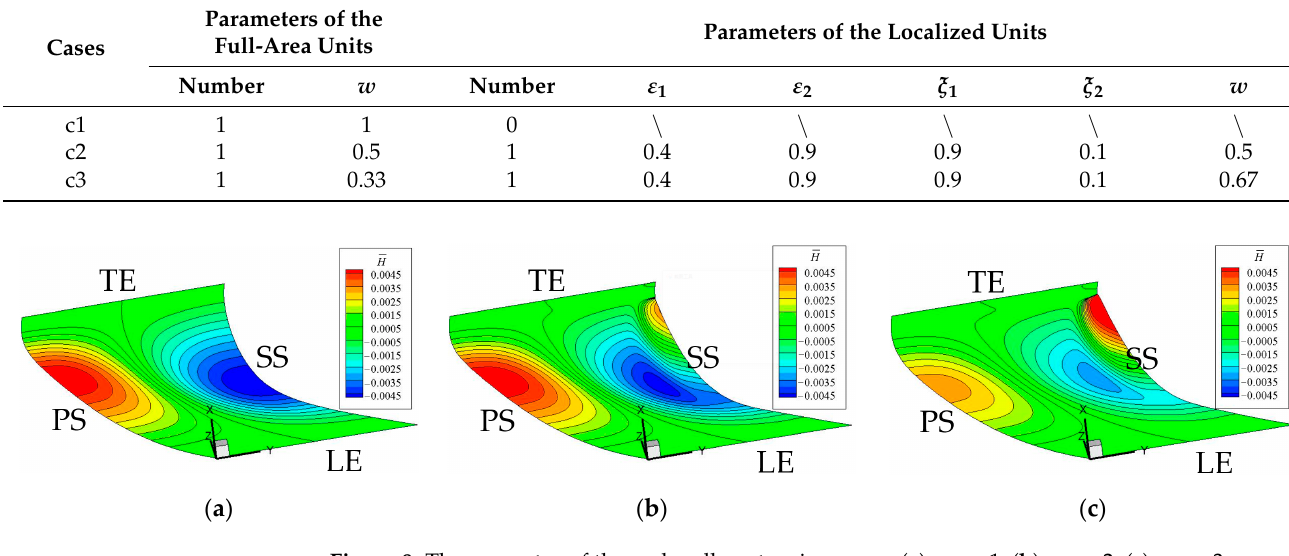
Table 3. The design parameter of the end wall contouring cases.